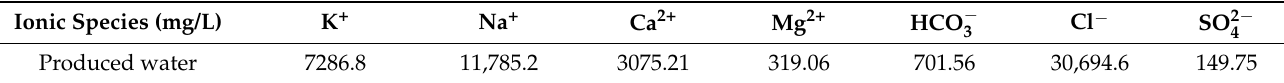
Table 2. Composition analysis results for the test